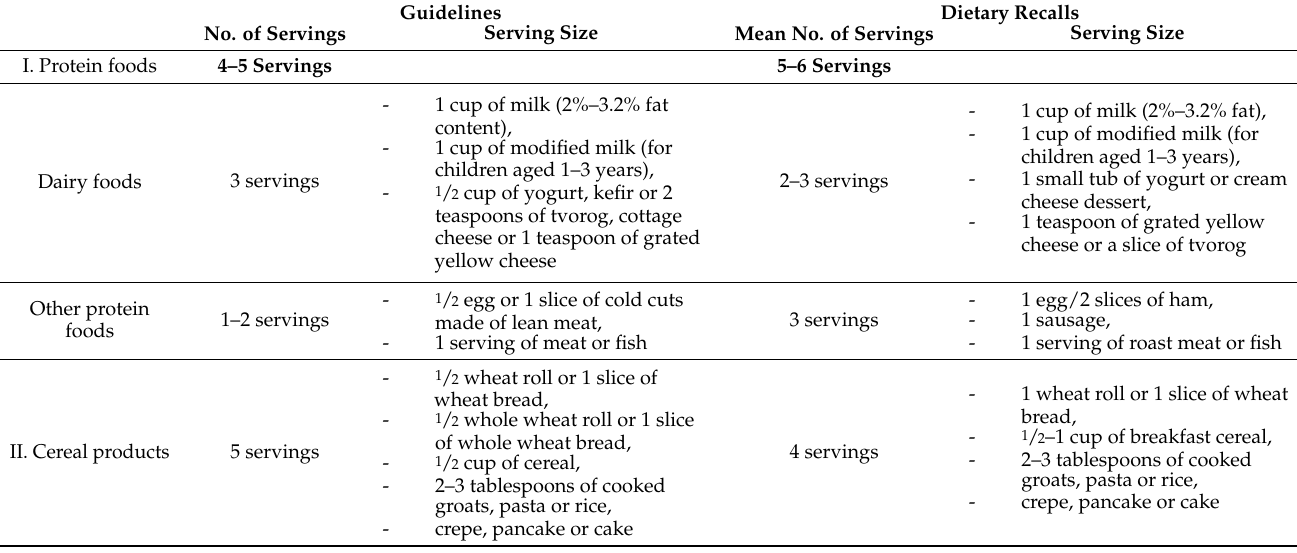
Table 1. The estimated number of servings and serving size of different food products in the daily rations of children aged 13–24 months and guideline values